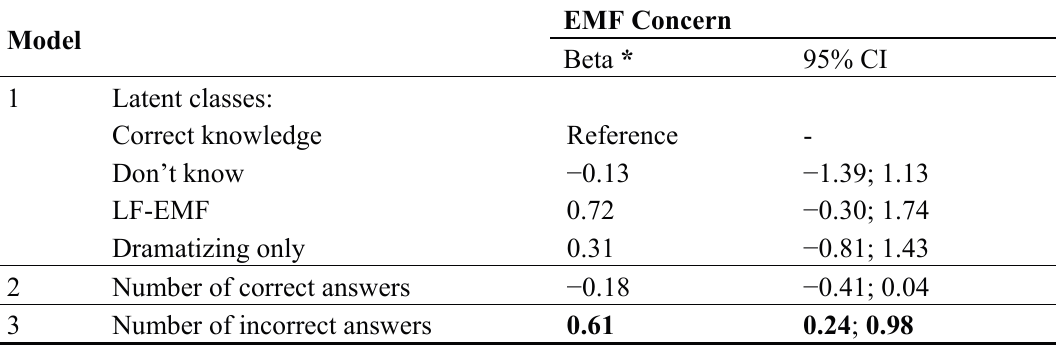
Table 5. Multiple linear regression models on the outcome “EMF concern” considering numbers of correct and incorrect answers, and latent knowledge classes, GPs in Germany